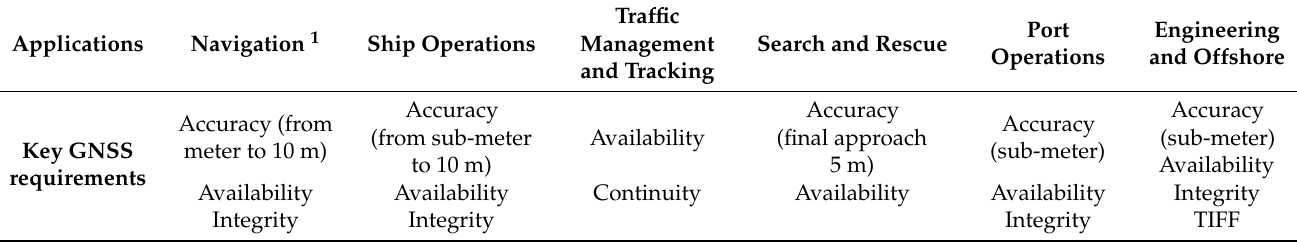
Table 3. High priority requirements for the maritime